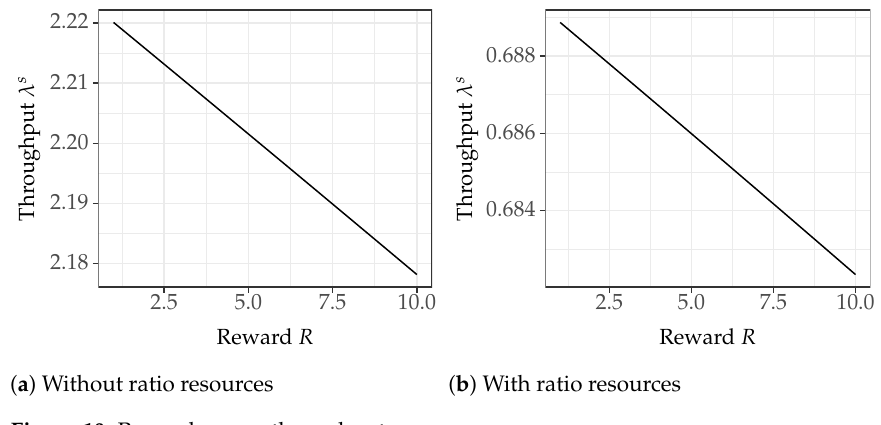
Figure 10. Reward versus throughput.